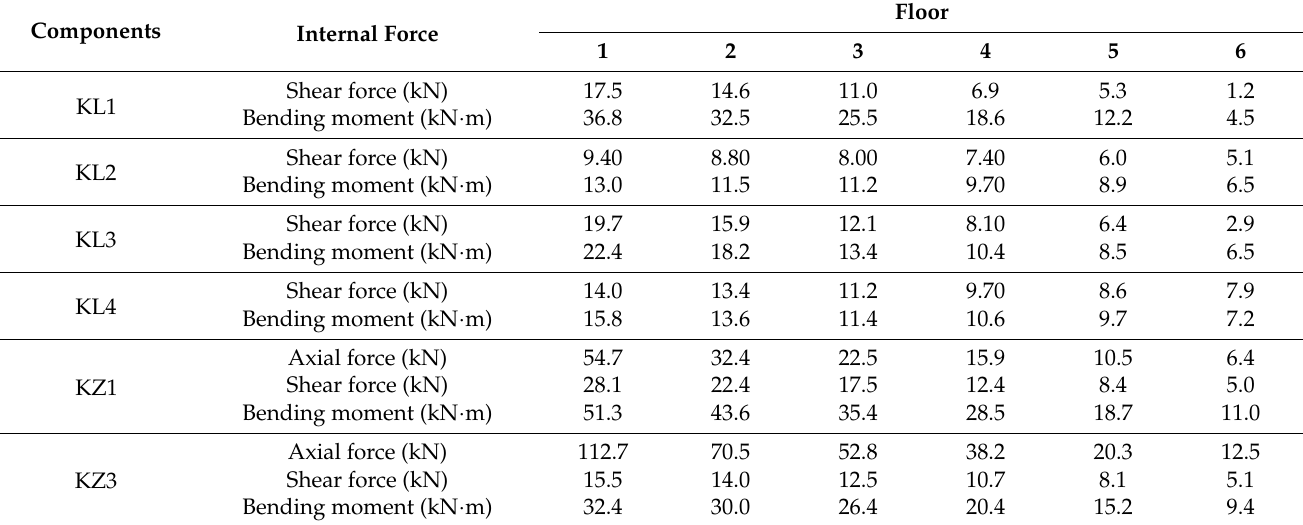
Figure 12. A comparison of the max interlayer shear forces of the